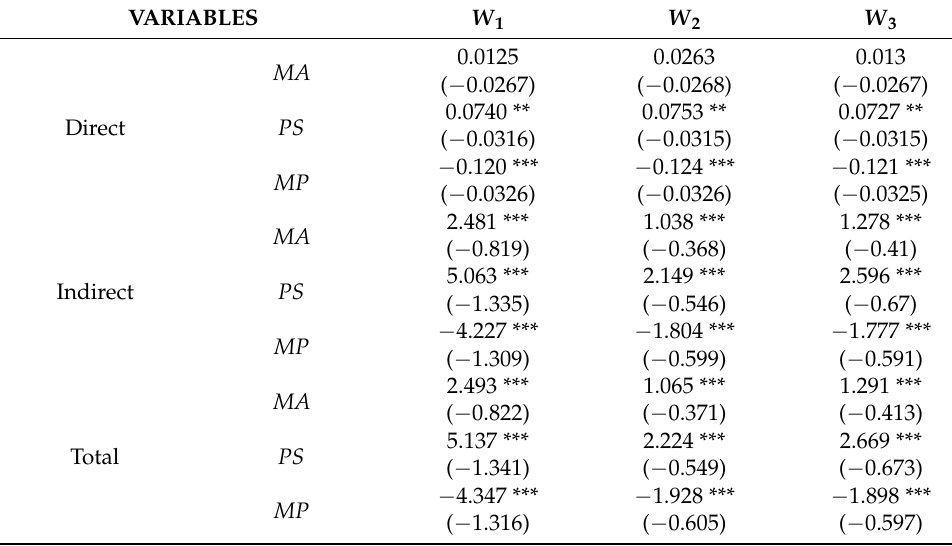
Table 6. Spatial effect decomposition of the spatial Durbin model.